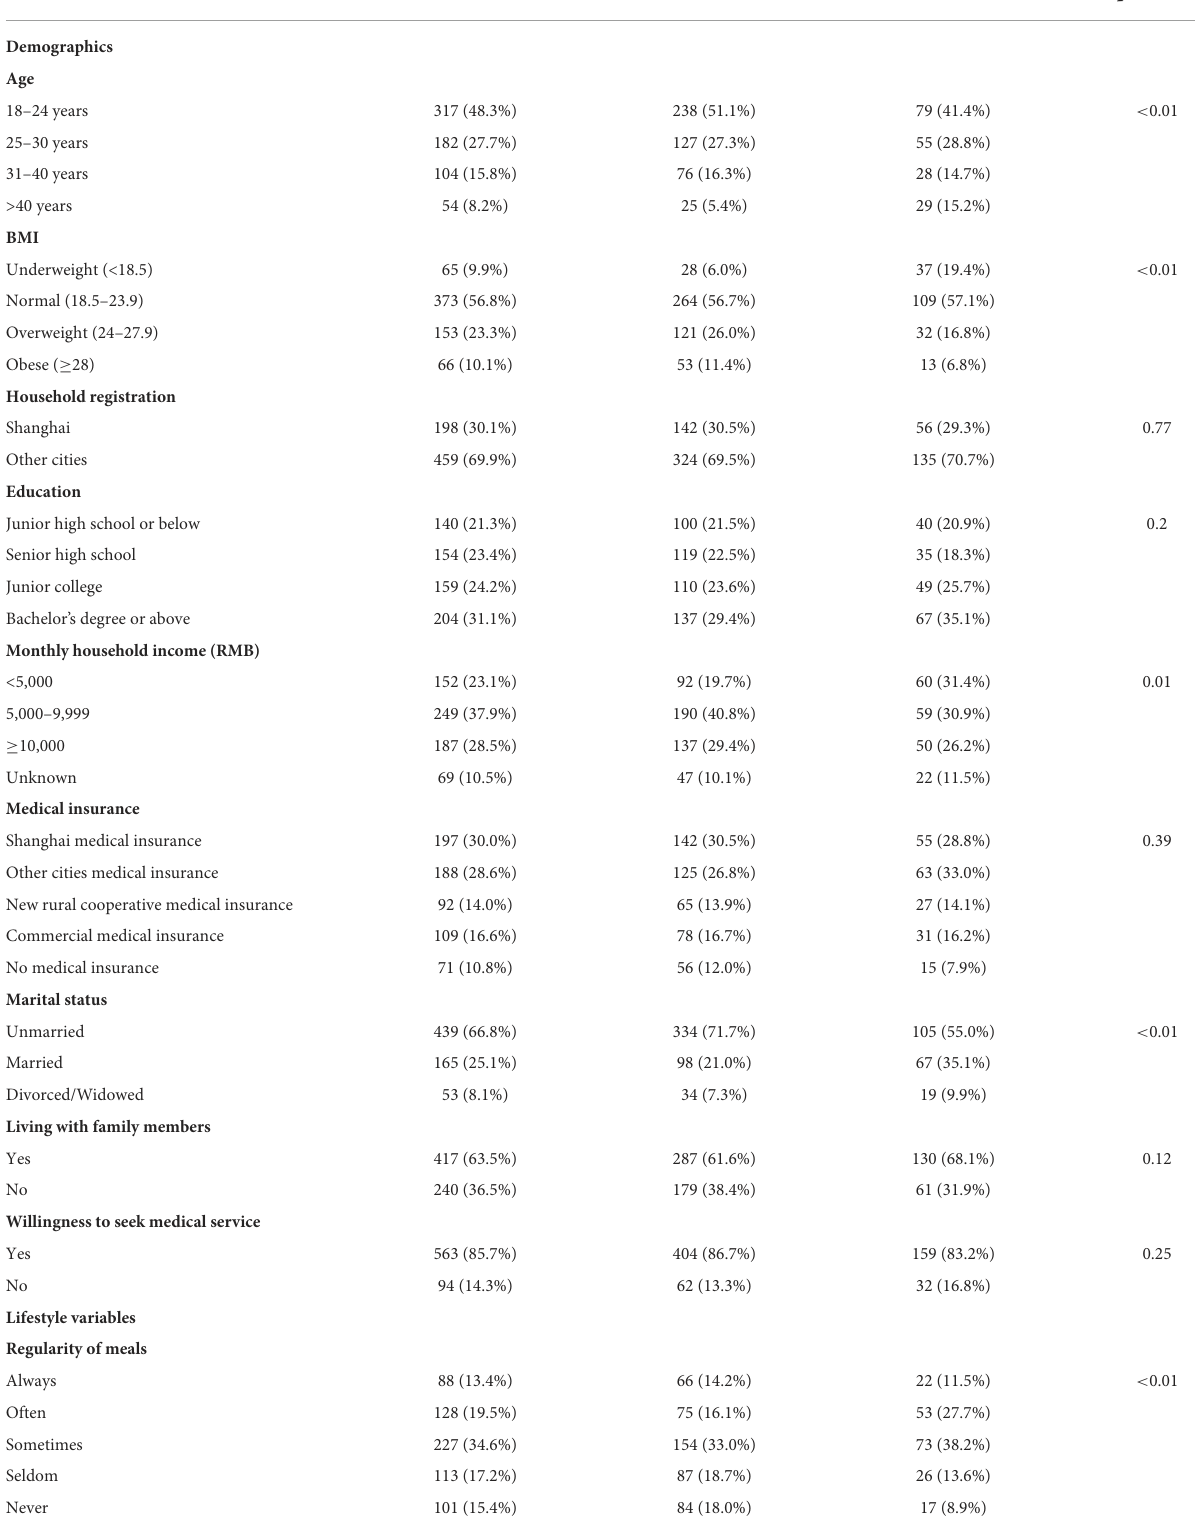
TABLE 1 Distribution of demographics and possible influencing